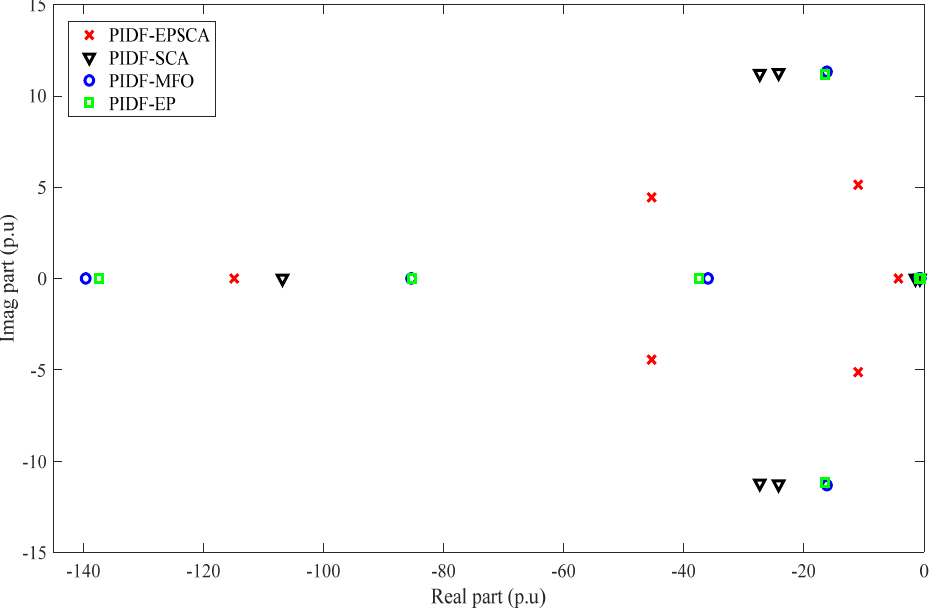
Figure 17. Eigenvalue distribution of the TCSC-PIDF controller system using PIDF-EPSCA, PIDF- SCA, PIDF-MFO, and PIDF-EP techniques for Scenario A-1.